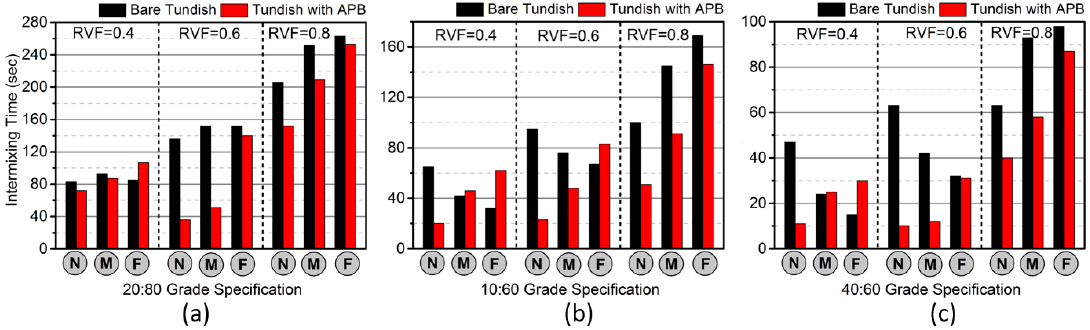
Figure 8. Intermixed amount calculated for the grade specifications from the F-curves of tundish: ( a ) 20:80, ( b ) 10:60, and ( c ) 40:60.